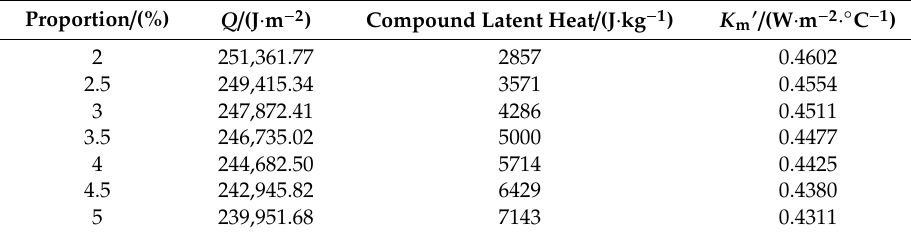
Table 3. Calculation results of di ff erent decanoic acid